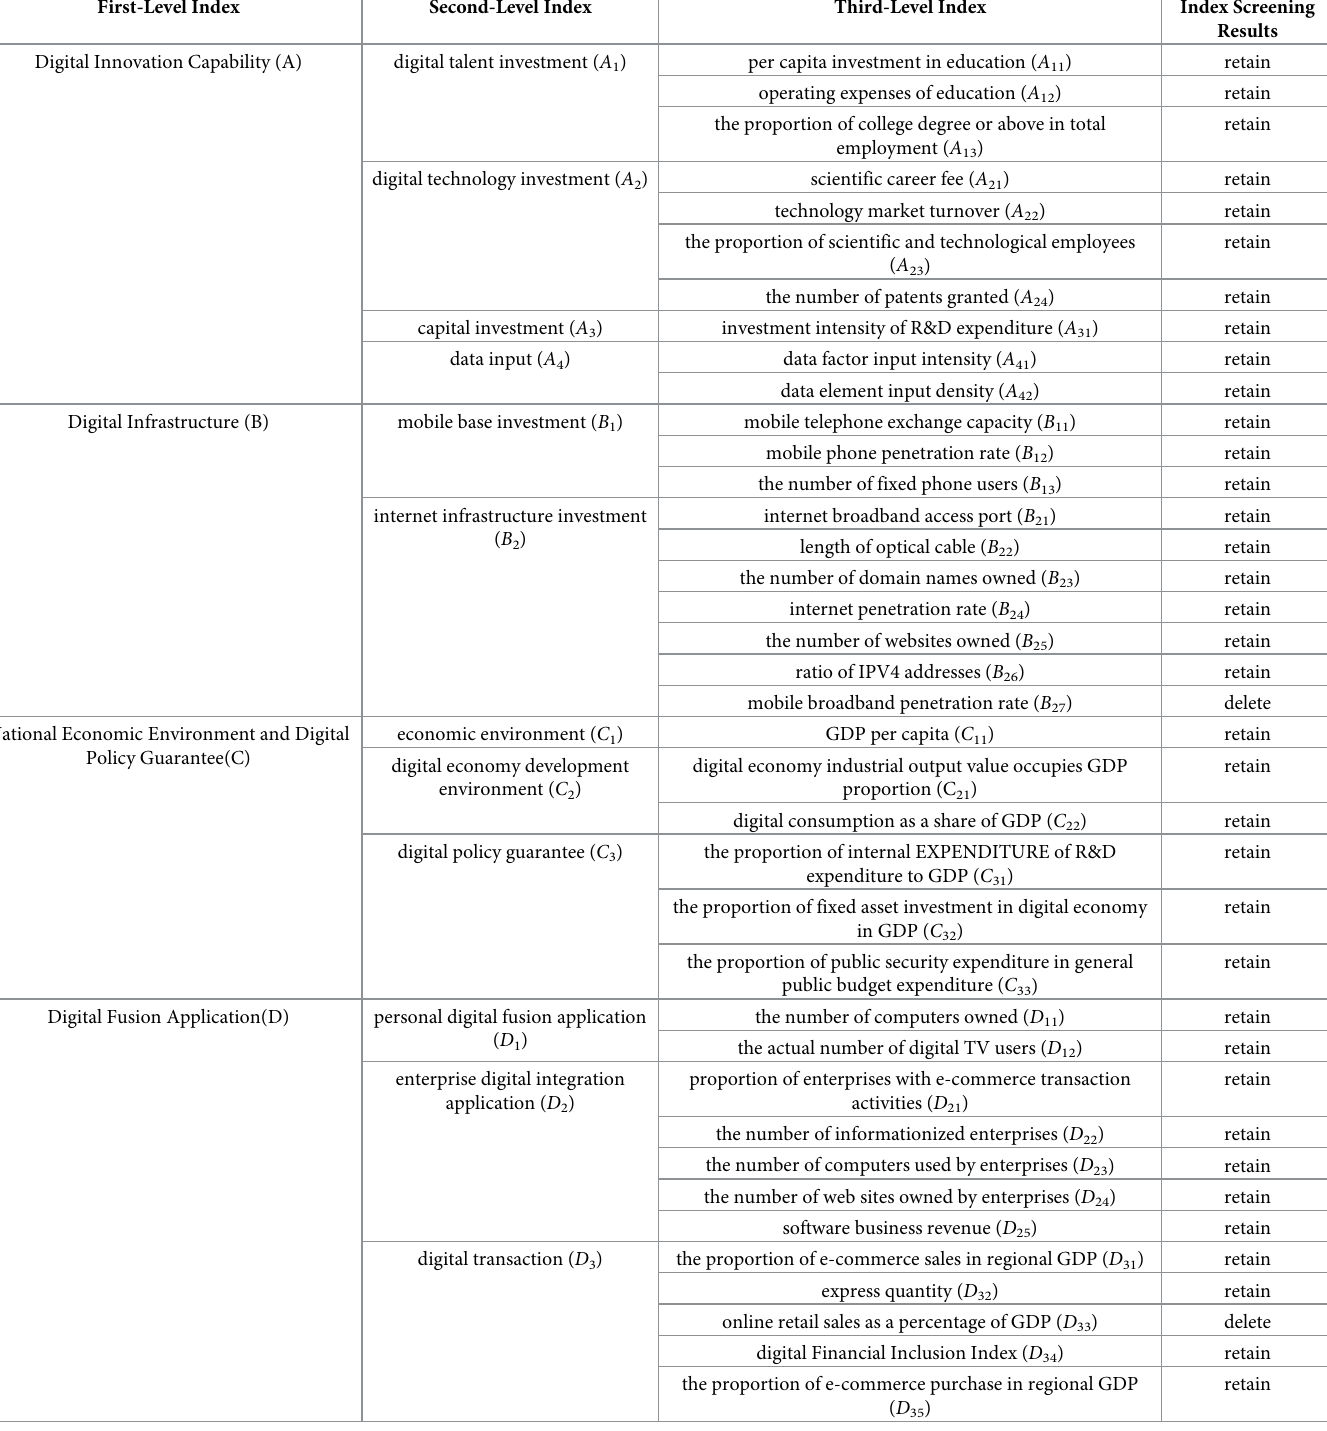
Table 1. The comprehensive evaluation index system of digital economy development